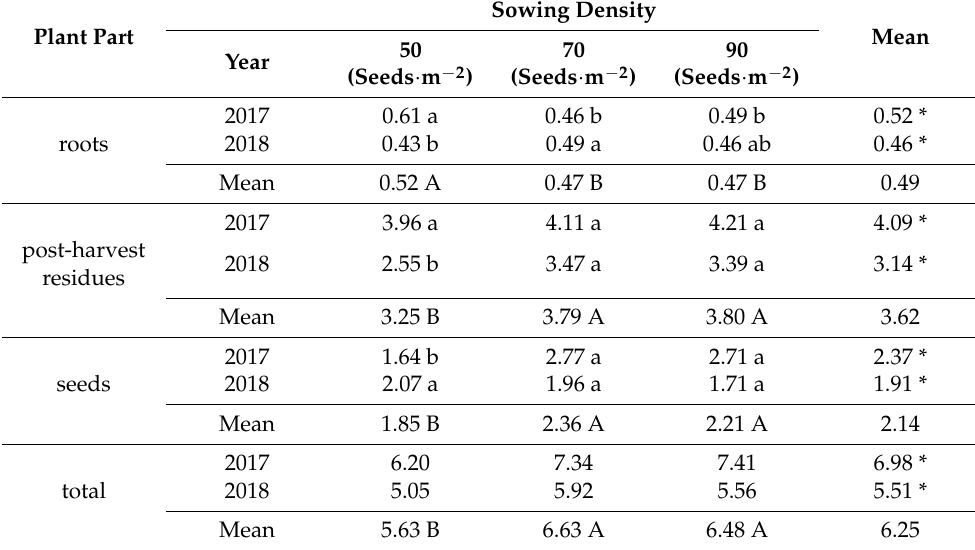
Table 2. The amount of soybean dry matter, Mg · ha − 1 .